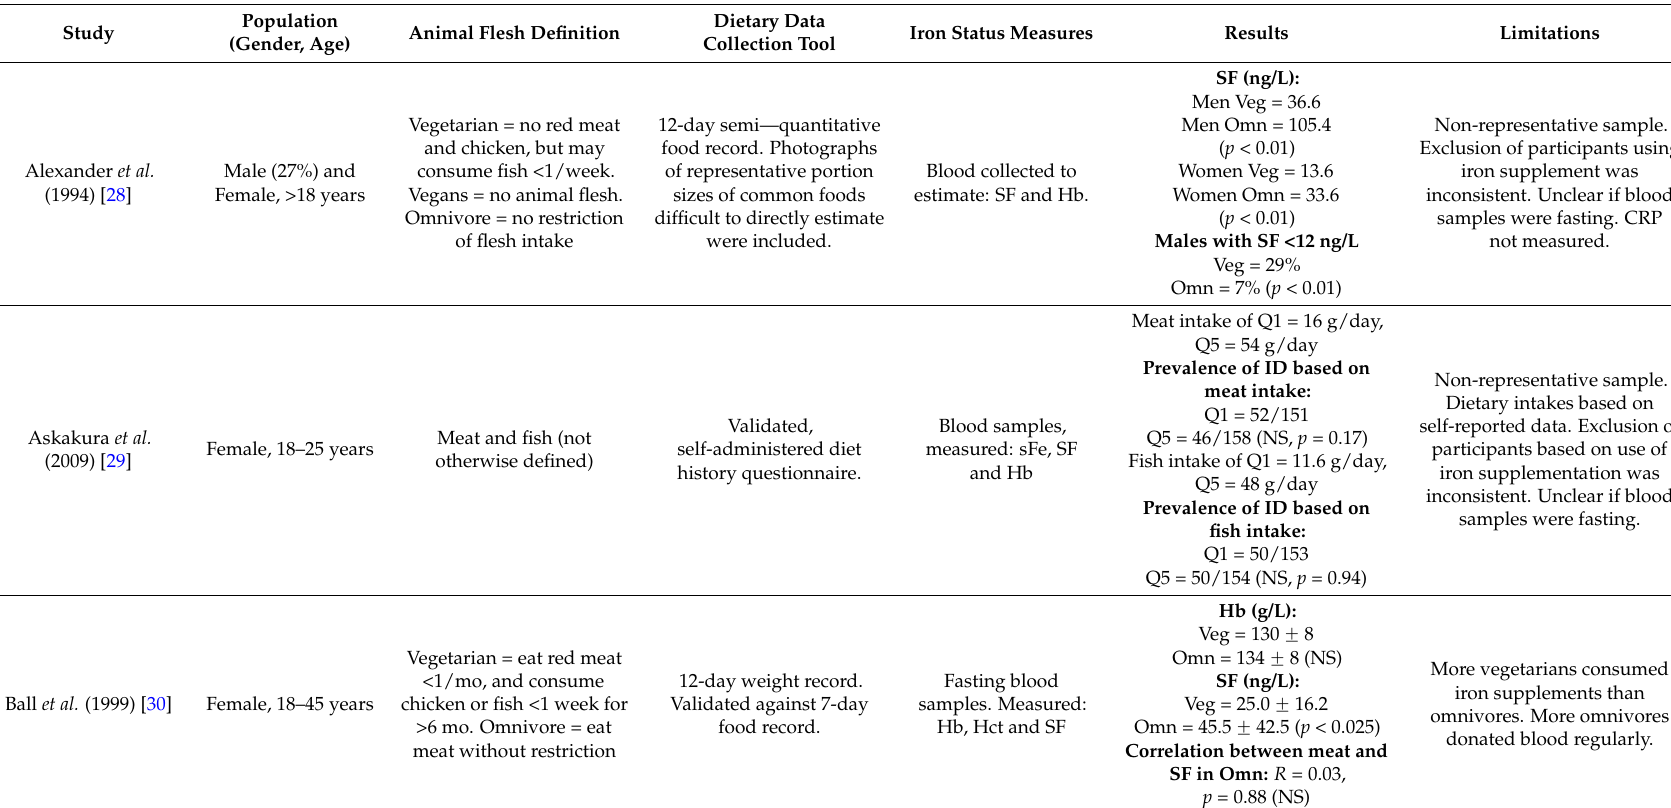
Table 2. Observational studies results: Intake of animal flesh foods and iron